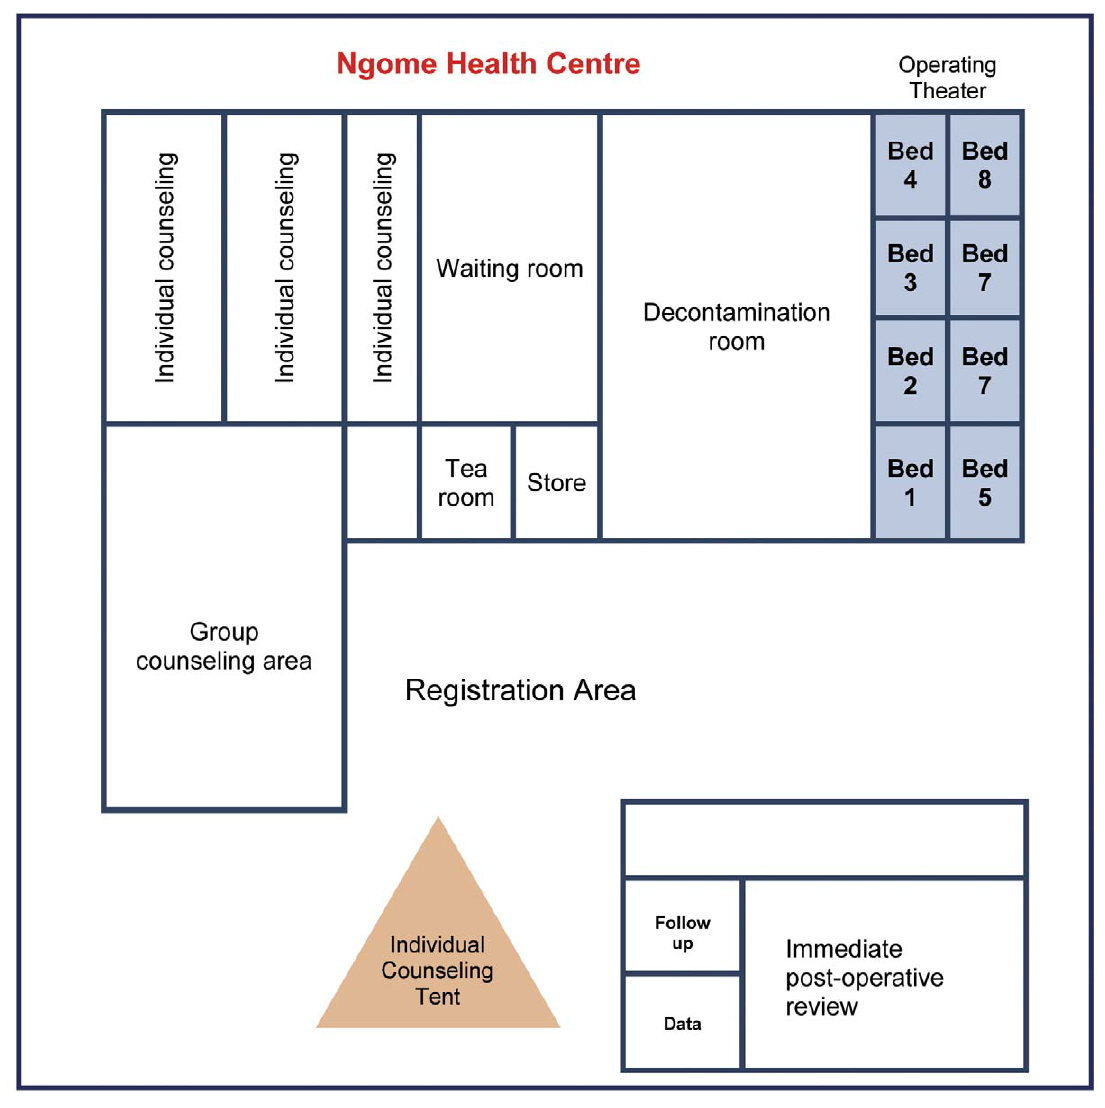
Figure 1. The layout of Ngome Health Centre. Before the campaign, this space was empty, having been built but not yet configured to function as a reproductive health facility. The Iringa Region team adapted the space for efficient VMMC service delivery by expanding the number of surgical bays (eight beds to accommodate two surgical teams), providing a large space for decontamination, increasing the number of individual counseling areas (including a tent to accommodate additional counselors), and including a separate postoperative area.